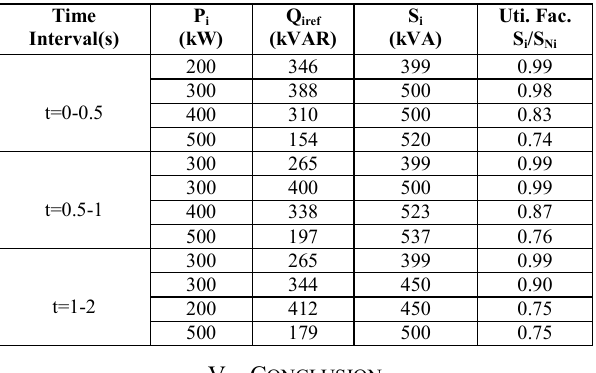
(c) Fig.10. Results with proposed algorithm (a)active power fed by DGs, (b)) reactive power shared by the inverters, (c)apparent power of each